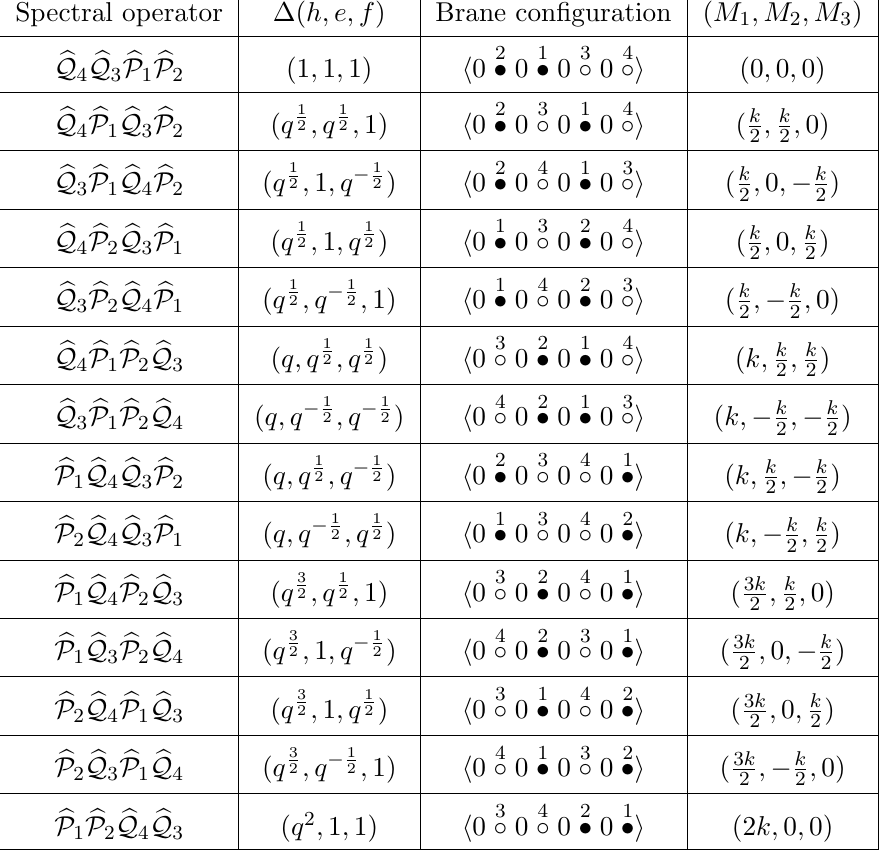
Table 3 . List of the quantum curves with a reference frame and labels speci(cid:12)ed in a general order and the corresponding brane con(cid:12)gurations. After changing into the standard order by commutation relation (2.29) for the quantum curves and by the Hanany-Witten transition (2.1) and (2.2), we (cid:12)nd a clear correspondence (3.9) between ( M 1 ; M 2 ; M 3 ) and (cid:1)( h; e; f